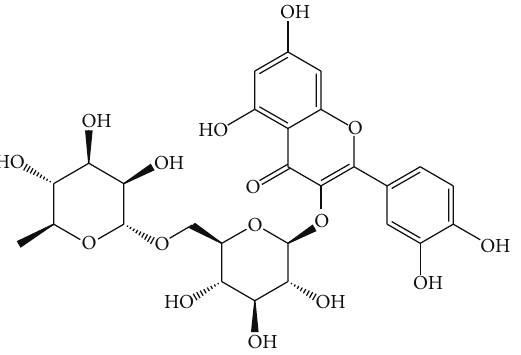
Figure 1: The chemical structure of rutin.